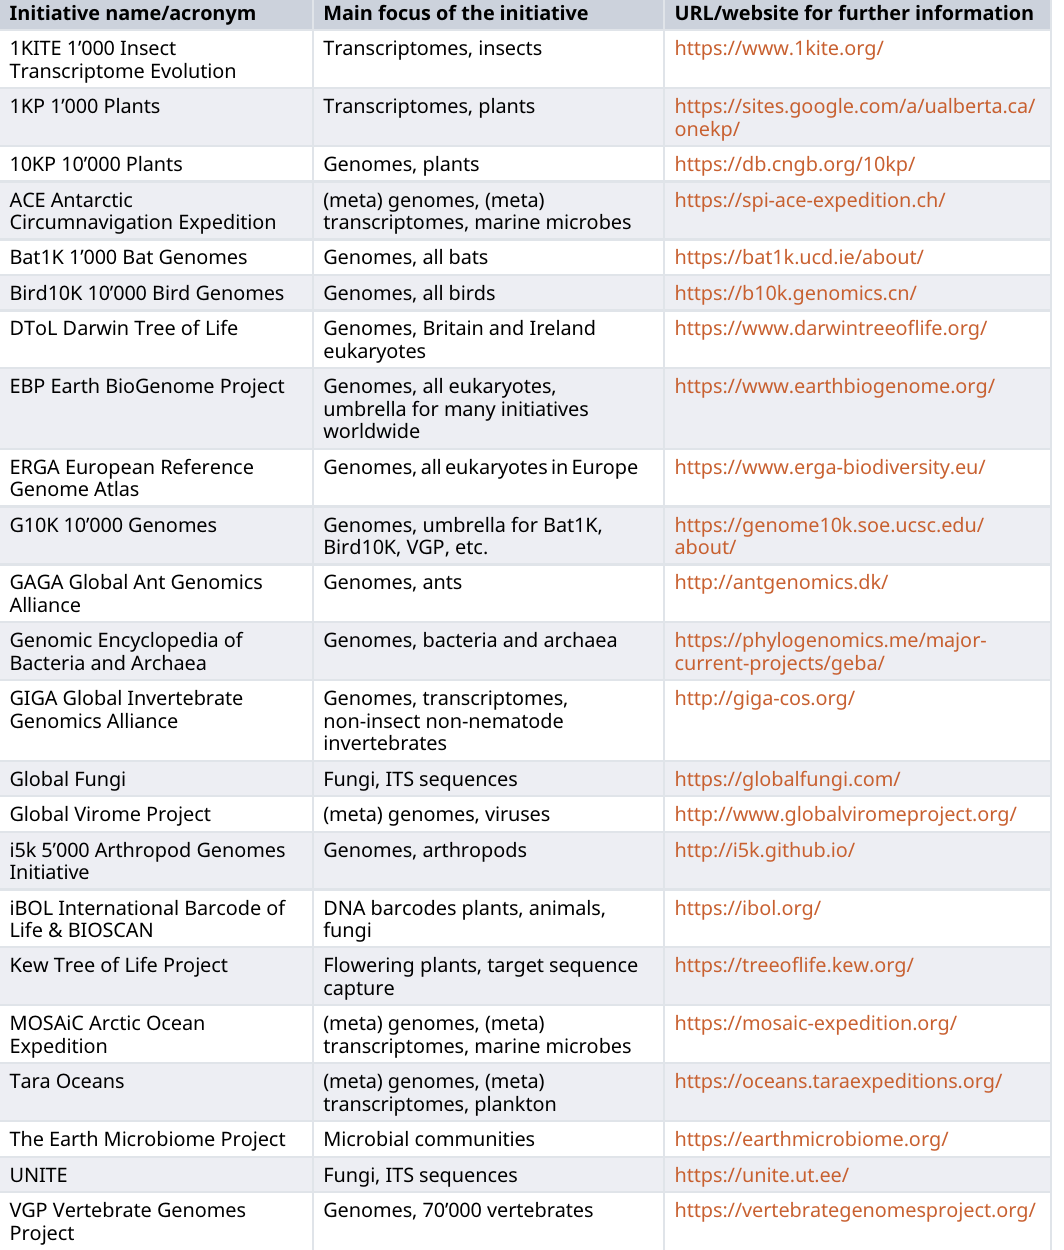
Table1.Examplesofmajormolecularsequencedatagenerationandcoordinationinitiatives. Anon-exhaustive list of active international projects and umbrella initiatives covering many species and producing (meta) genomes, (meta) transcriptomes, and/or DNA barcodes, with public data